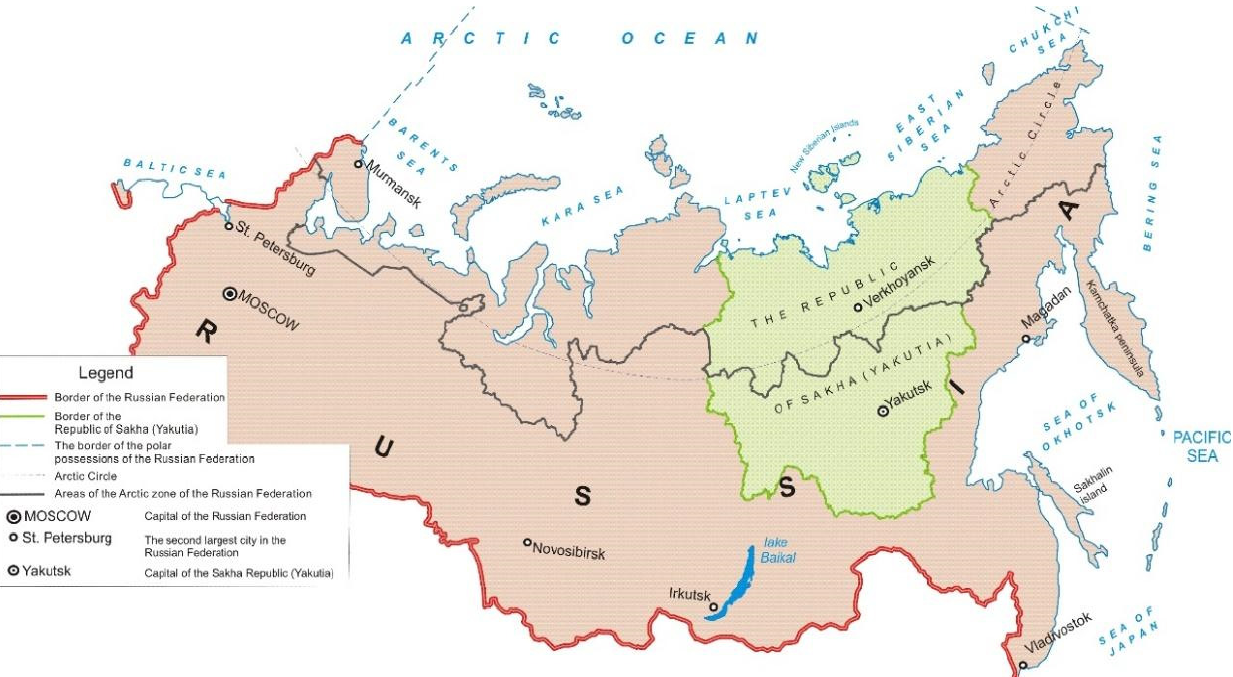
Figure 1. Location of the Sakha Republic into Russian Federation.